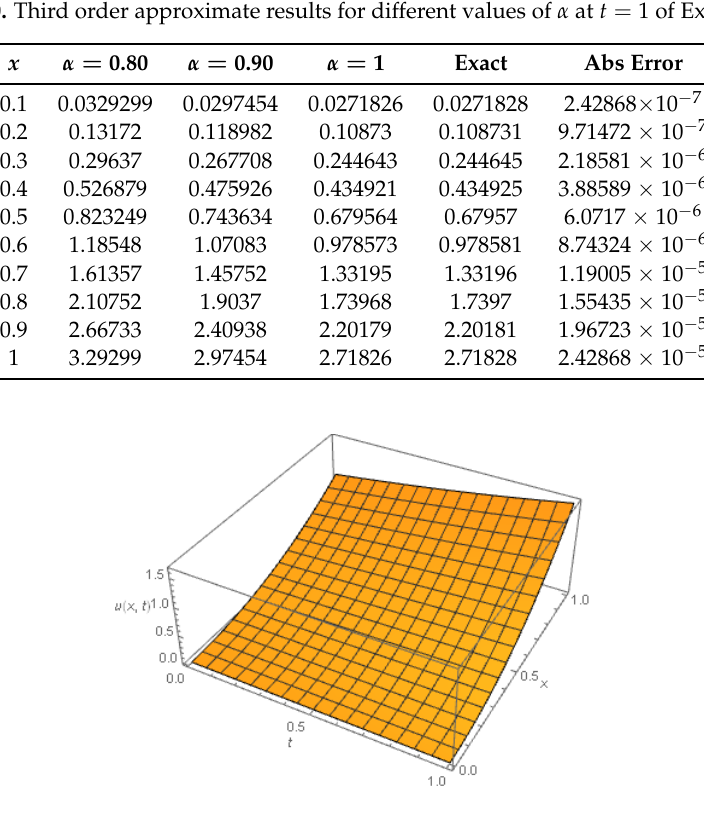
Figure4: Absolute error of example1 at (cid:11) = 1